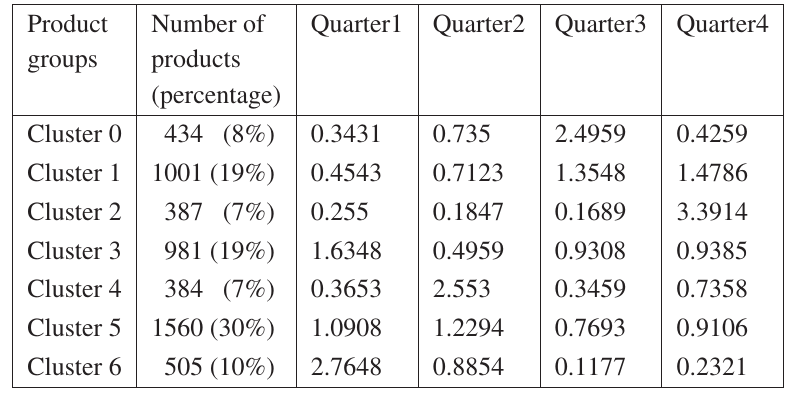
Table 13. Tier-1 quarterly seasonality analysis in